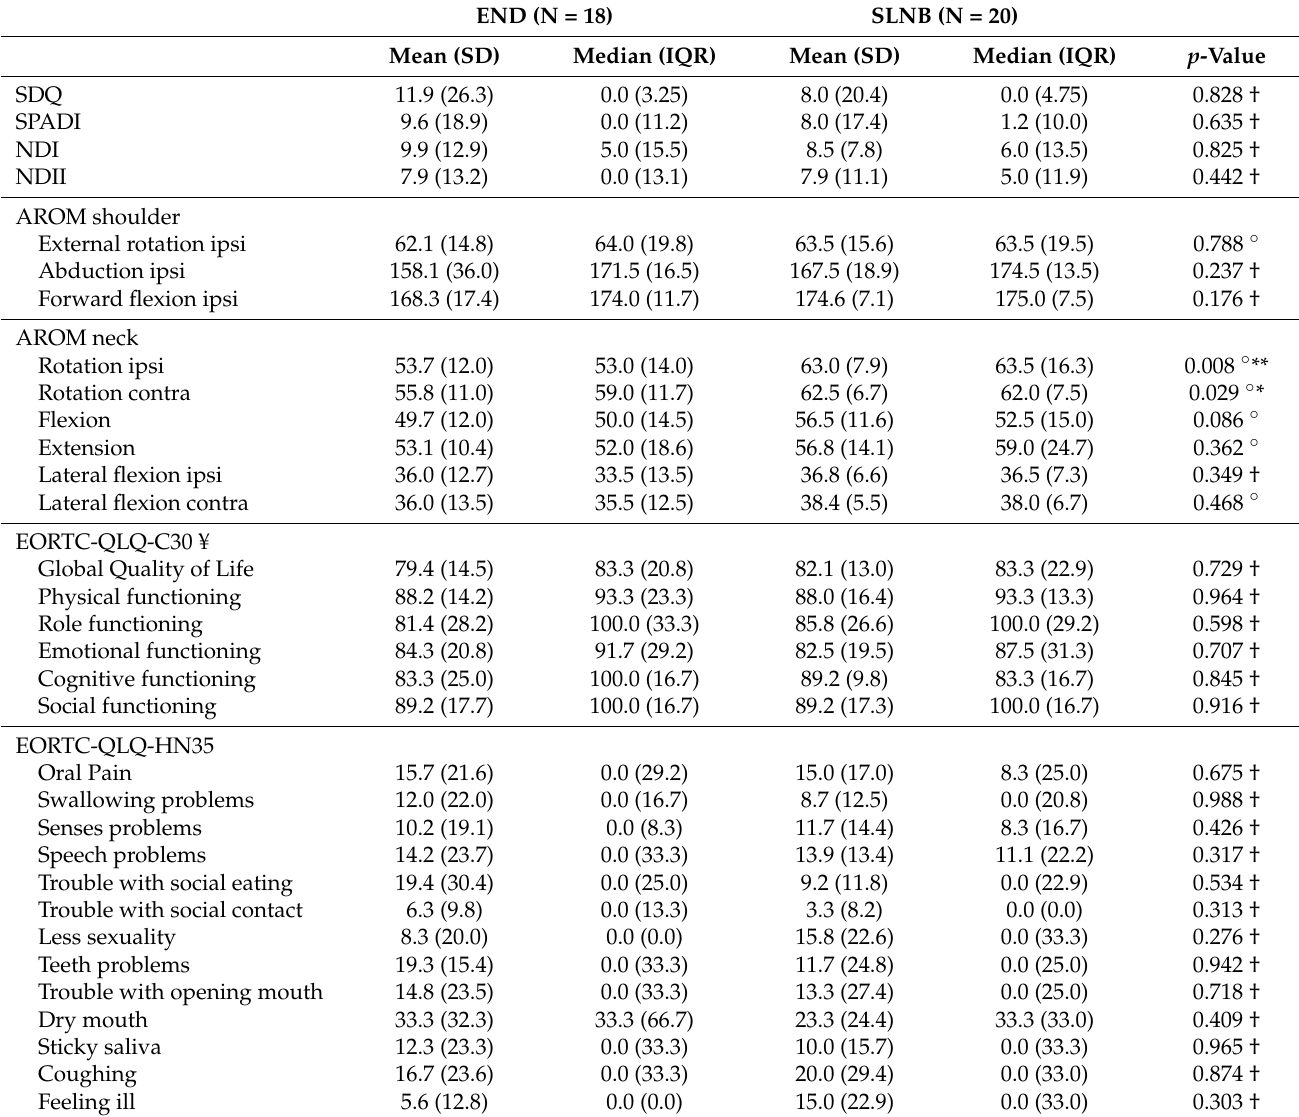
Table 2. Morbidity and active range of motion of neck and shoulder and health related quality of